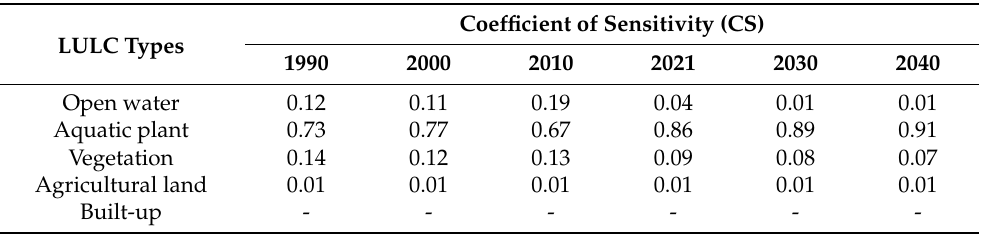
Table 12. Coefficient of sensitivity (CS) value of different LULC classes based on Costanza et al.’s (1997) ESV value.